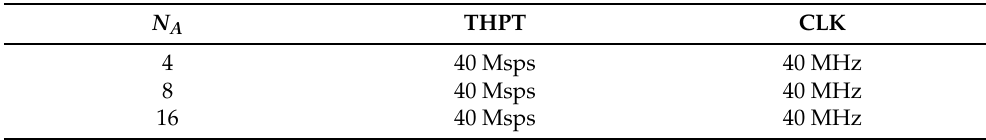
Table 4. Processing speed of the